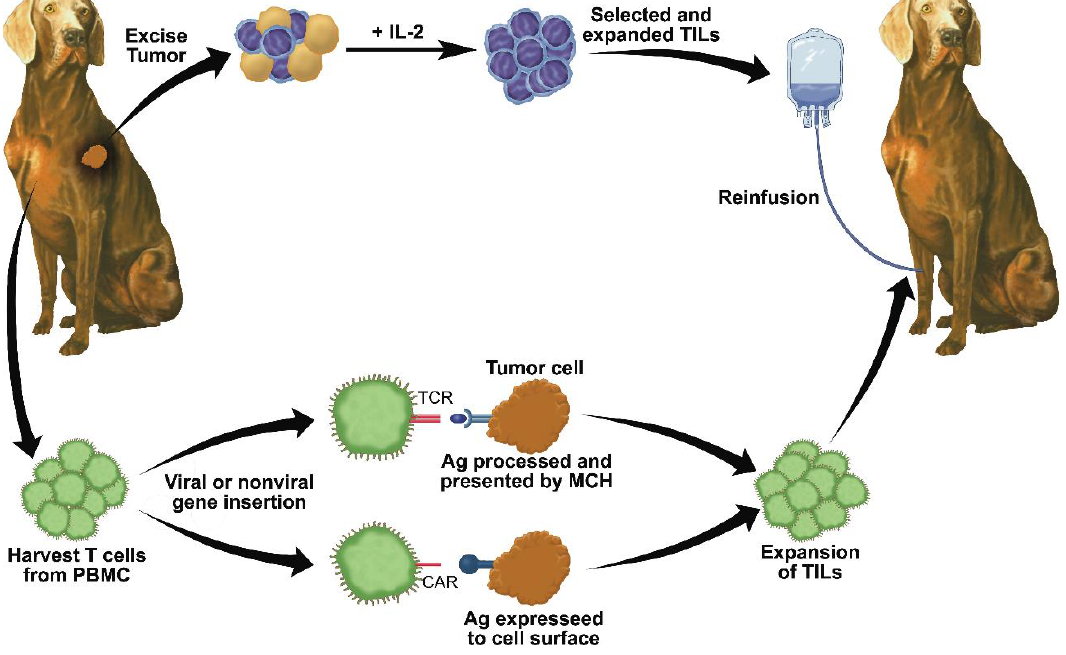
Figure 4. Approaches to adoptive T cell therapy. In the top scheme, a resected tumor sample is digested into a single cell suspension and cultured in the presence of IL-2 to select for naturally occurring tumor-infiltrating lymphocytes (TILs). The TILs are then expanded, tested for anti-tumor activity, and reinfused into the patient. In the bottom scheme, autologous T cells are harvested from the blood and either a transgenic T cell receptor (TCR) or a chimeric antigen receptor (CAR) is introduced by viral or non-viral transduction. TCRs are capable of recognizing a specific tumor antigen presented in the context of an MHC molecule. CARs are MHC-independent and capable of directly recognizing an antigen on the tumor cell surface. Following transduction, the transgenic T cells are expanded and